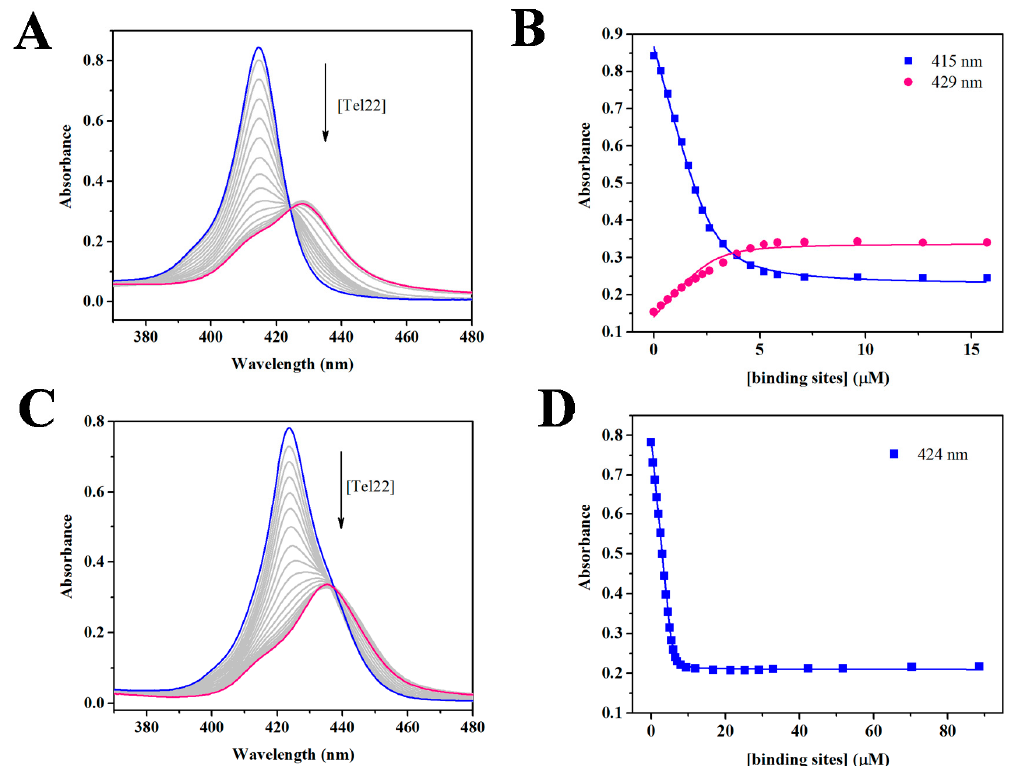
Figure 2. Interactions between porphyrins and Tel22 GQ probed by UV-Vis spectroscopy. ( A ) A representative UV-Vis titration of 2.8 µM TCPPSpm4 with 82.6 µM Tel22. Clear isosbestic point is observed at 424 nm. ( B ) Best fit (solid line) to the titration data monitored at 415 nm (squares) and 429 nm (circles). ( C ) A representative UV-Vis titration of 5.8 µM ZnTCPPSpm4 with 46.3 (followed by 185) µM Tel22. Clear isosbestic point is observed at 442 nm. ( D ) Best fit (solid line) to the titration data monitored at 424 nm (squares). Concentration of binding sites is defined as the concentration of Tel22 multiplied by the binding stoichiometry (4:1 for TCPPSpm4 and 12:1 for ZnTCPPSpm4). Blue lines and points correspond to porphryins alone and pink corresponds to porphyrin-Tel22 complex.